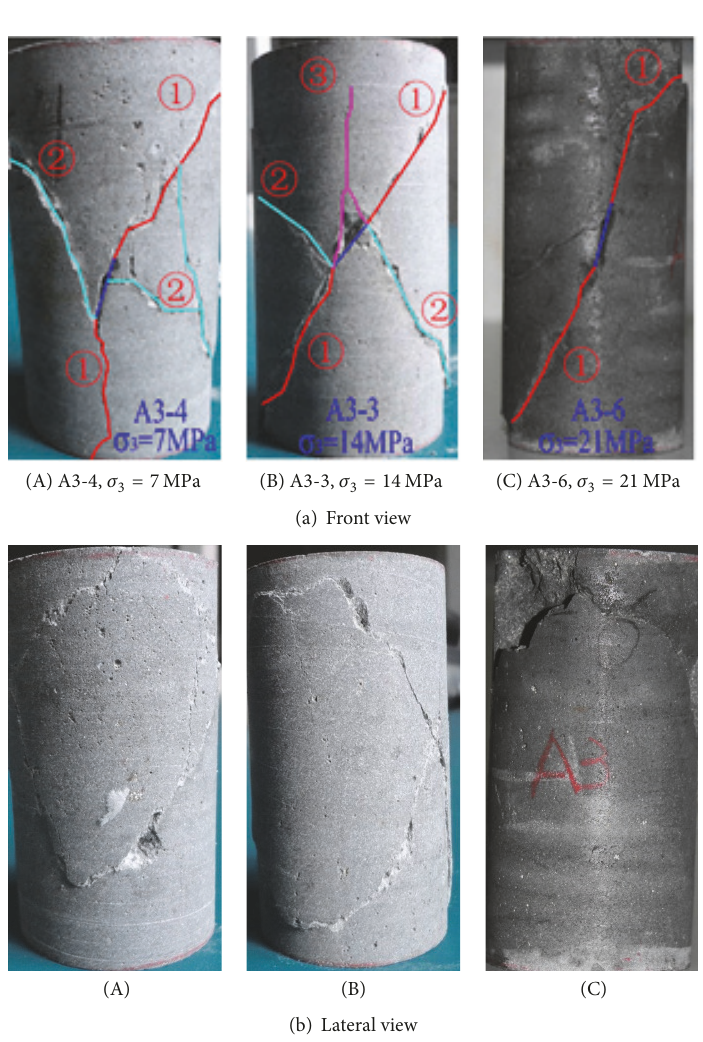
Figure 8: Fracture modes of specimens with different confining